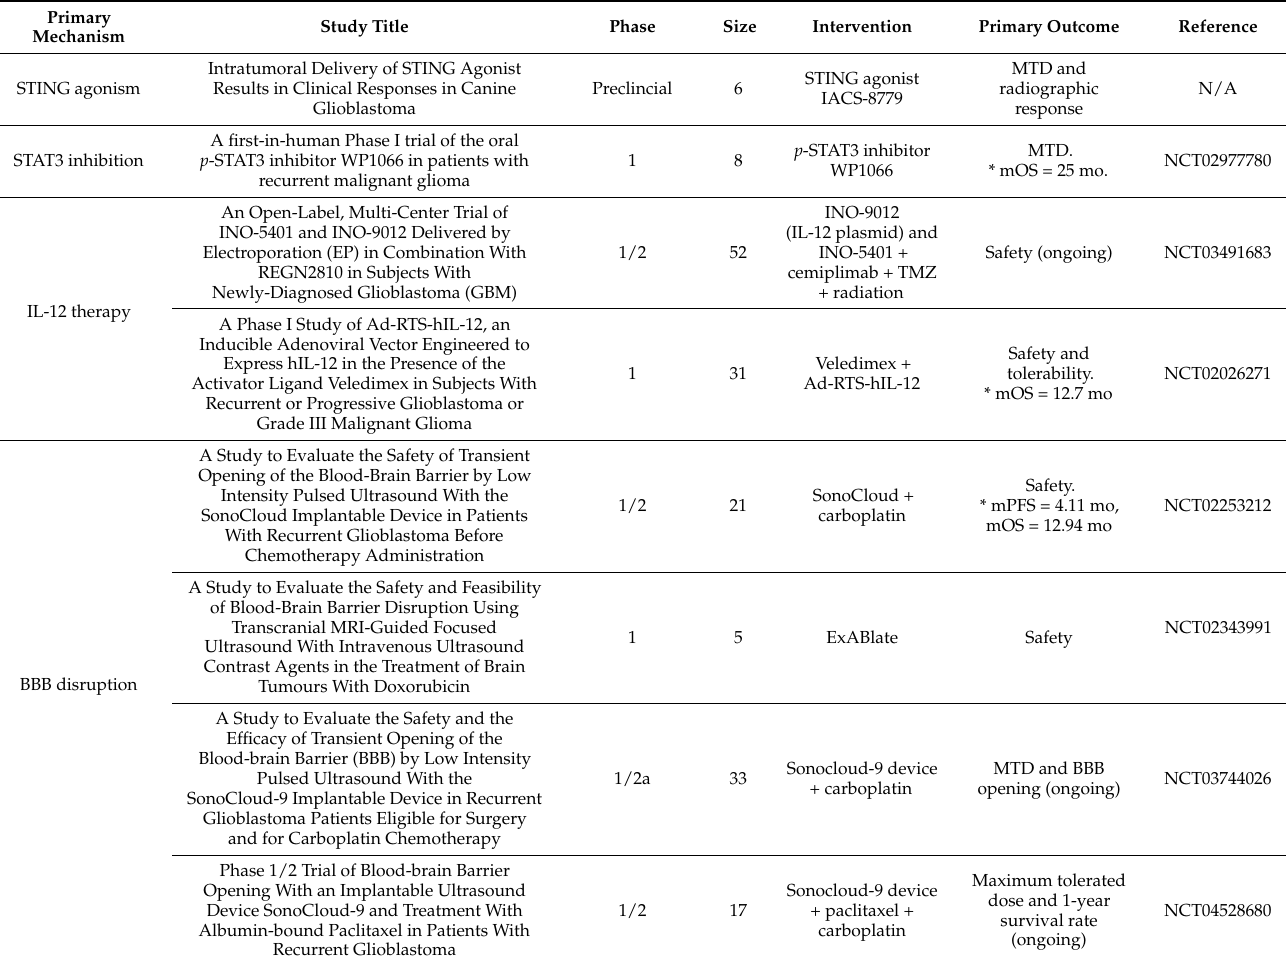
Table 6. Clinical trials aimed at enhancing immunotheraeutic response in